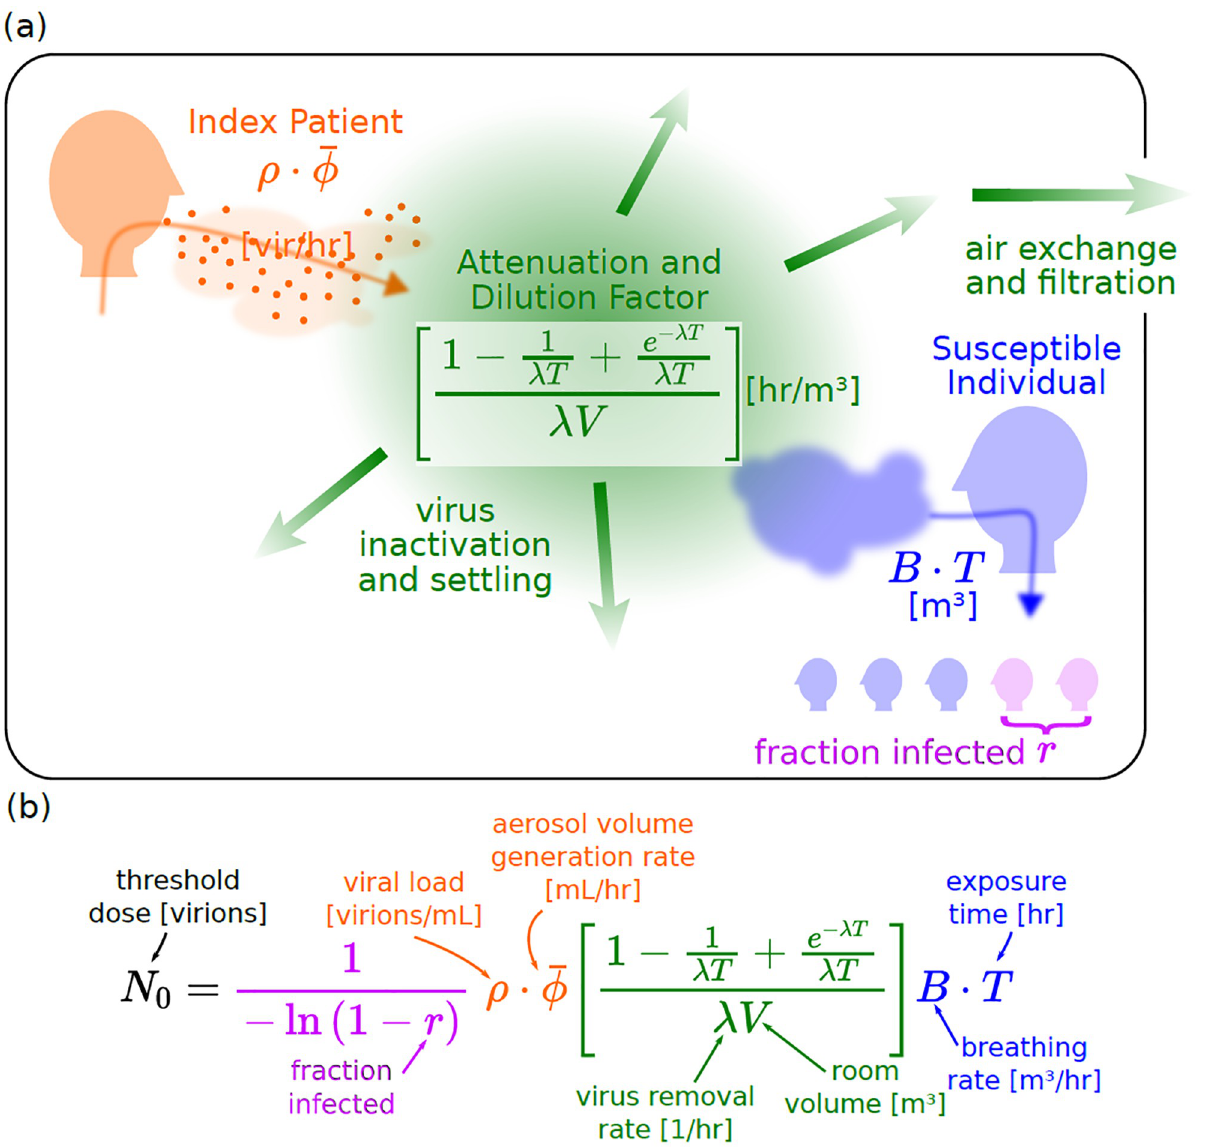
Fig 1. (a) A visual representation of the various terms used in part (a), illustrating their physical origin. (b) Equation describing how an estimate for the threshold dose for infection, N 0 , can be inferred from case data. The equation naturally divides into several components, one originating from medical data on virion emission rates for index patients, another that amounts to an effective room volume and incorporates environmental factors, a term that accounts for the volume inhaled by the patient, and one from epidemiological data on the attack